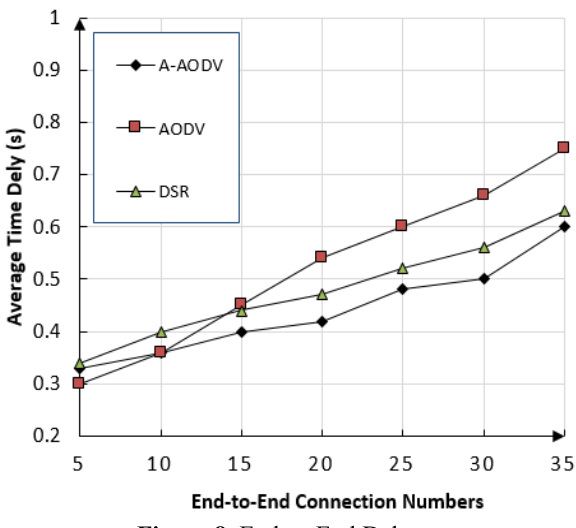
Figure 8. End-to-End